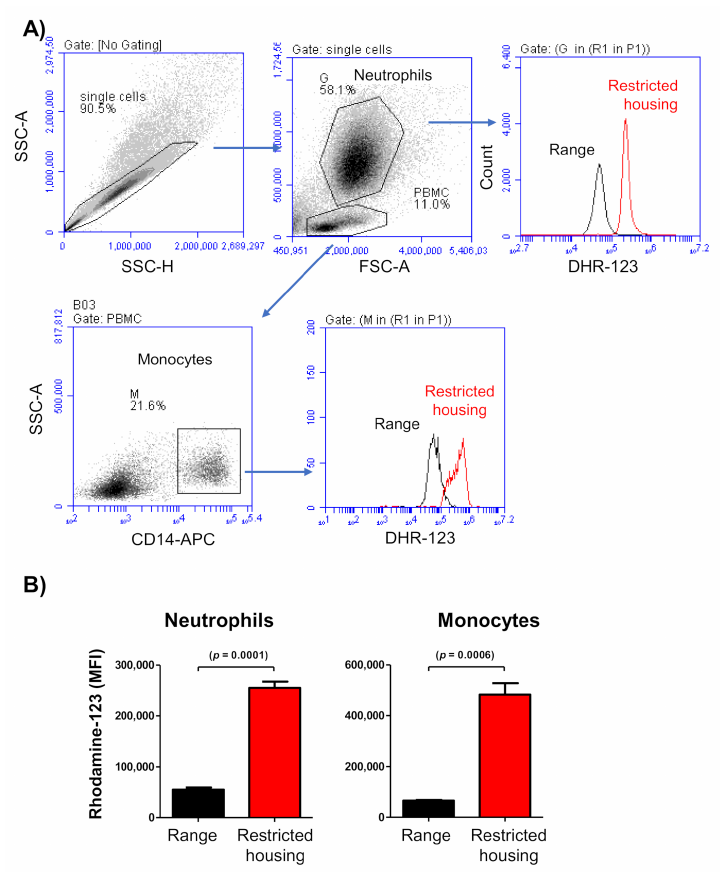
Figure 2. Reactive oxygen species (ROS) levels in monocytes and neutrophils. Leukocytes separated from camel blood were labeled with DHR-123, which detects ROS metabolites. ( A ) Labeled cells were analyzed by flow cytometry. After gating on single cells using SSC-A against SSC-H, neutrophils were identified based on their higher SSC signal. Monocytes were identified as CD14-positive cells within the PBMC population. ROS amount in neutrophils or monocytes was measured as median fluorescence intensity of DHR-123. Cells from free-range and housed camels are compared using an FL-1-histogram. ( B ) ROS MFI values are presented graphically for neutrophils and monocytes (student t